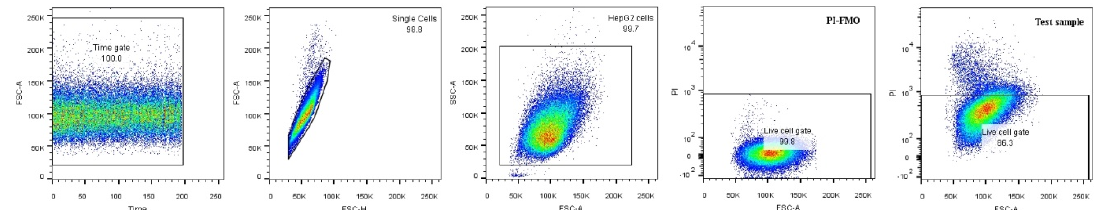
Figure 9. Gating strategy in the flow cytometry analysis.